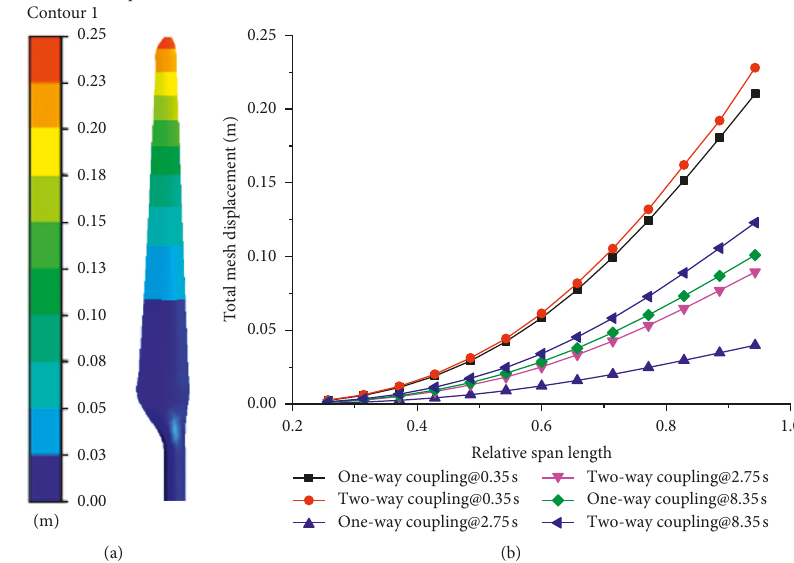
Figure 8: Displacement along the blade span direction at different times under one- and two-way FSIs: (a) displacement distribution contour of the blade under FSI; (b) displacement curves along the blade span at a rated wind